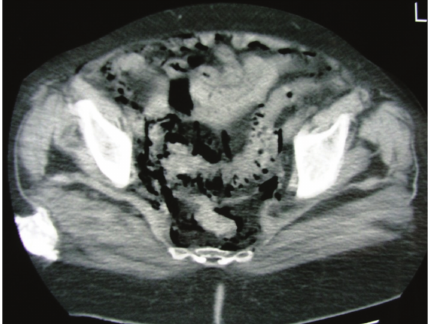
Figure 5: Excessive amount of free air surrounding the sigmoid colon and